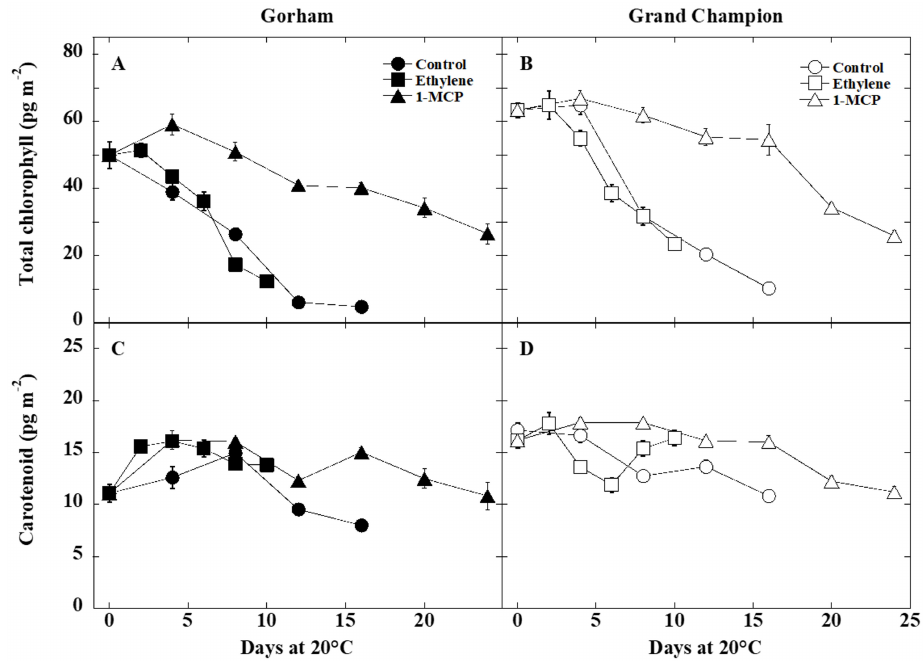
Figure 4. Changes in total chlorophyll ( A , B ) and carotenoid ( C , D ) concentration of ‘Gorham’ and ‘Grand Champion’ fruit treated with ethylene and 1-MCP during ripening at 20 ◦ C. Values represent the means ± standard errors ( n = 5).